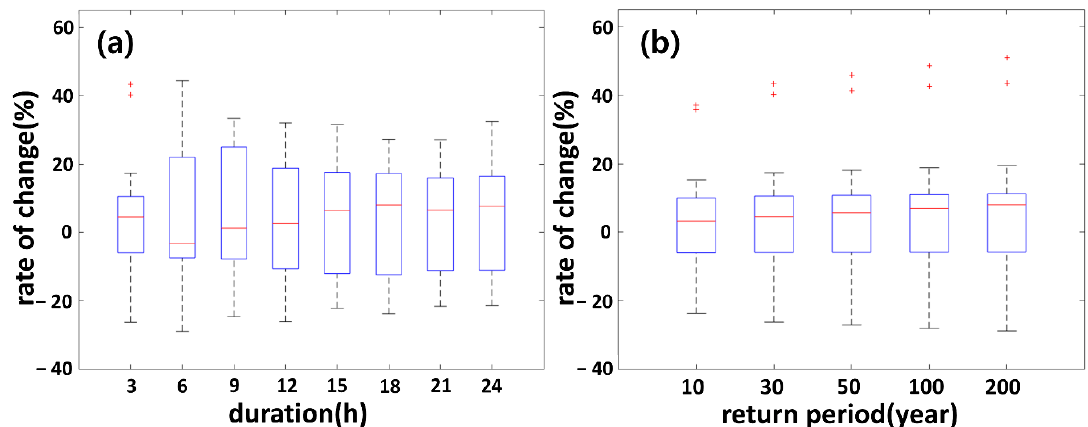
Figure 14. Boxplot of rates of change ( a ) for duration (return period 30 years), and ( b ) return period (duration 3 h) at the Seoul site.